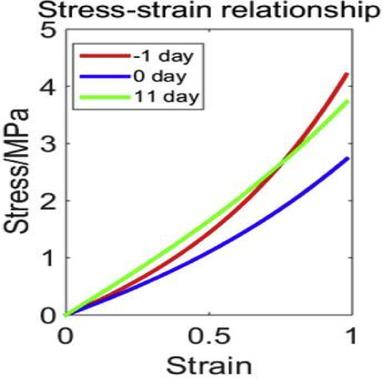
Strain-stress curves.